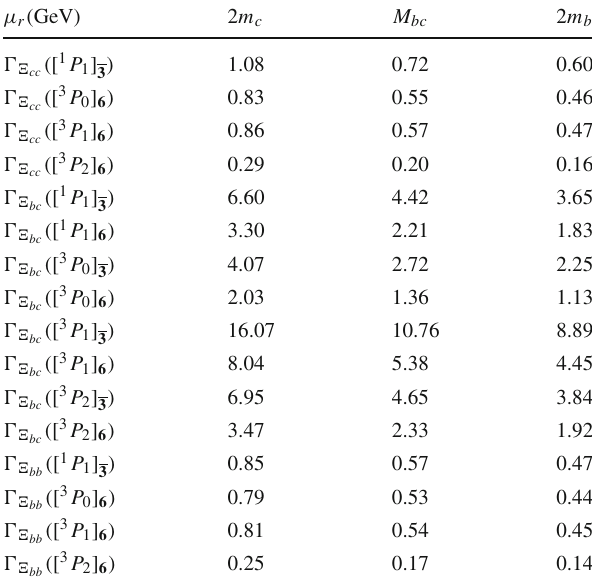
Table 6 Theoretical uncertainty caused by the renormalization scale for the production of P -wave (cid:2) QQ (cid:4) by substituting μ r = 2 m c , M bc